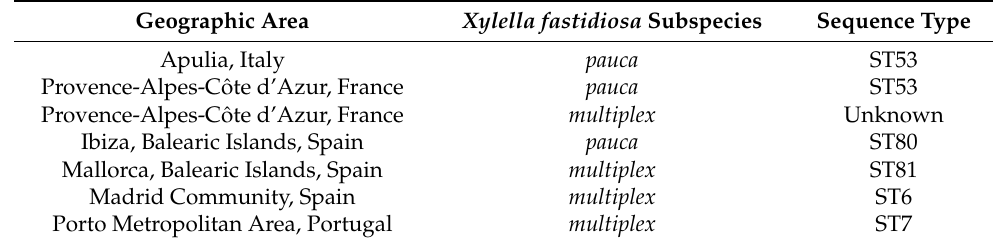
Table 1. Reported occurrence 1 of Xylella fastidiosa subspecies in olive ( Olea europaea L.) trees in the EU. Geographic Area Xylella fastidiosa Subspecies Sequence Type Apulia, Italy pauca ST53 pauca ST53 multiplex